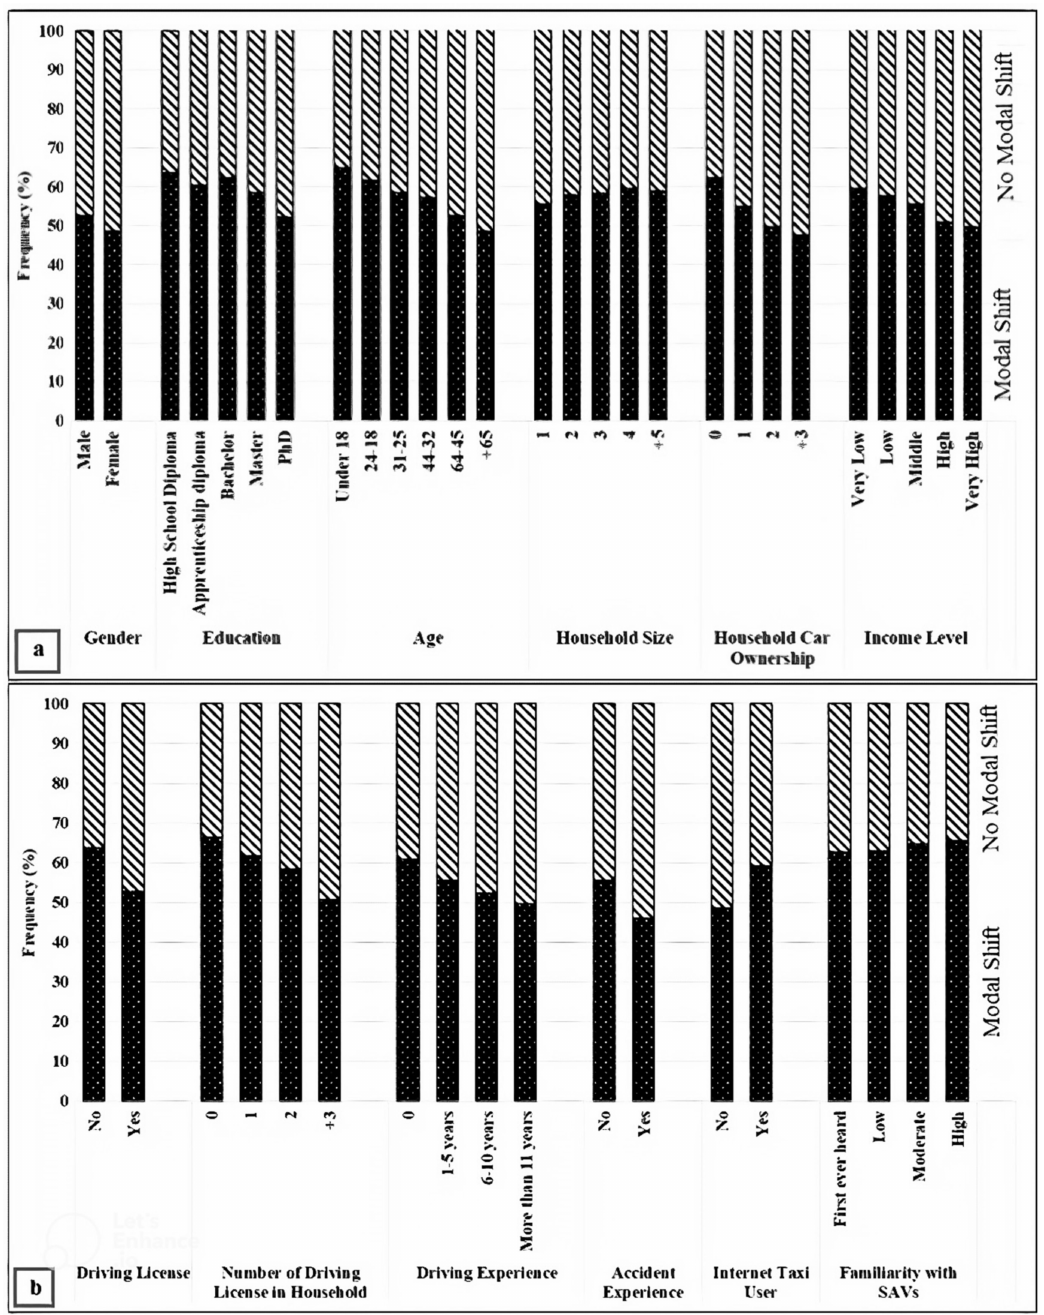
Figure 3. Frequency analysis of the modal shift preference to SAVs by ( a ) socio-economic characteris- tics and ( b ) travel-related